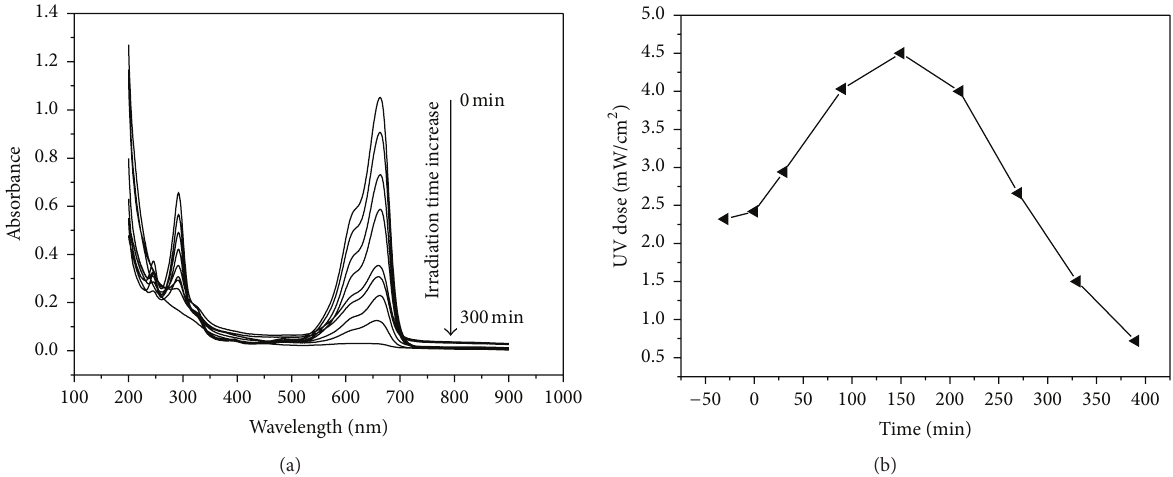
Figure 5: (a) Change in the absorption spectrum of MB solution within 5 hours of illumination and (b) the measured solar UV doses at different time intervals of the degradation